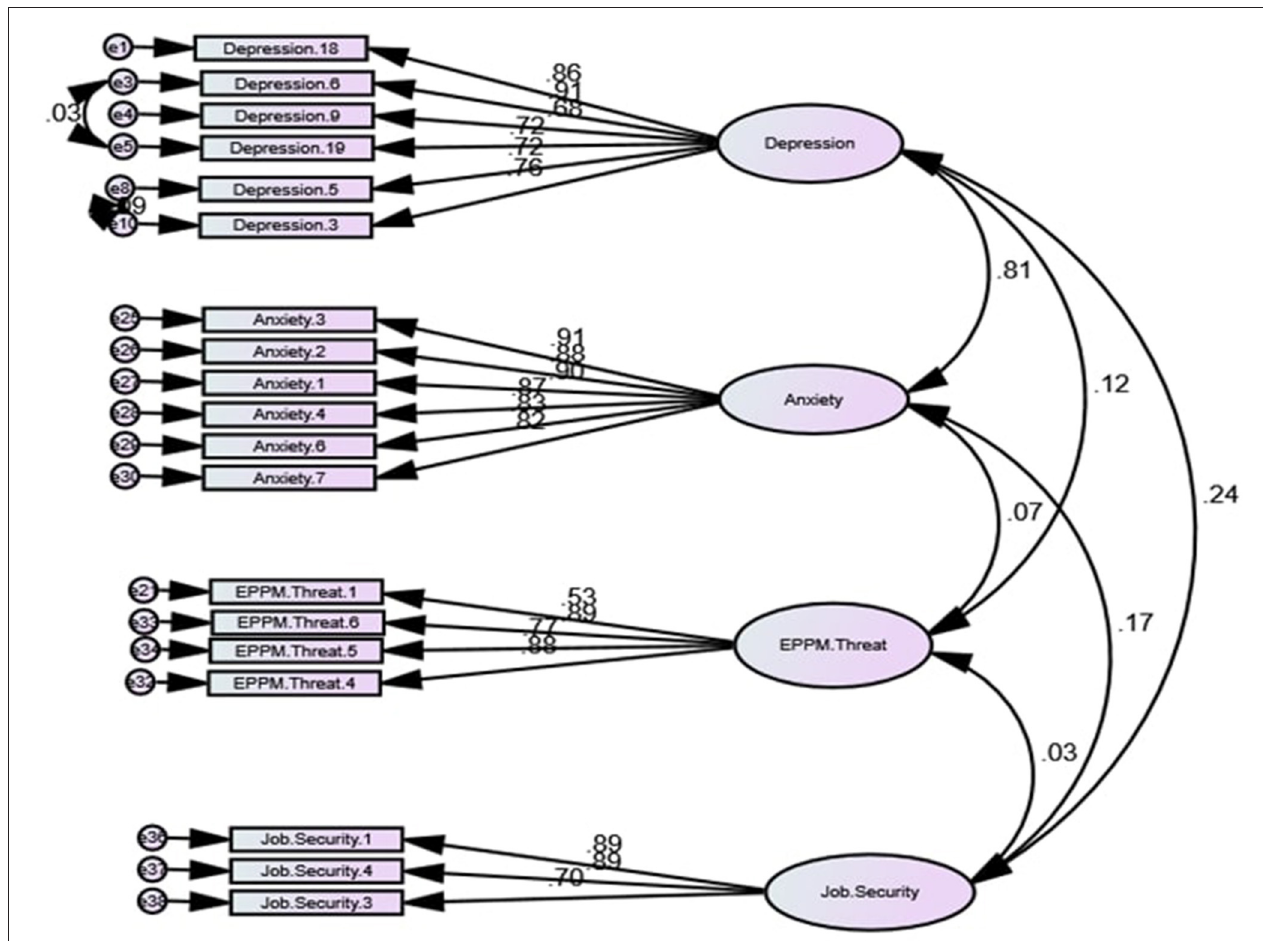
FIGURE 2 | Measurement